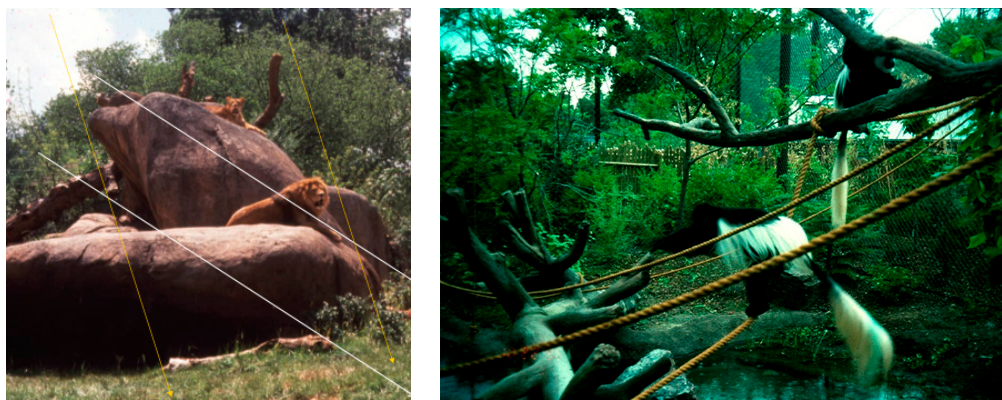
Figure 3. ( Left ) artificial geology designed to optimize solar azimuth for the lions’ comfort at Zoo Atlanta. ( Right ) artificial branch designed to sway naturally at the Denver Zoo (Photos: J. Coe).